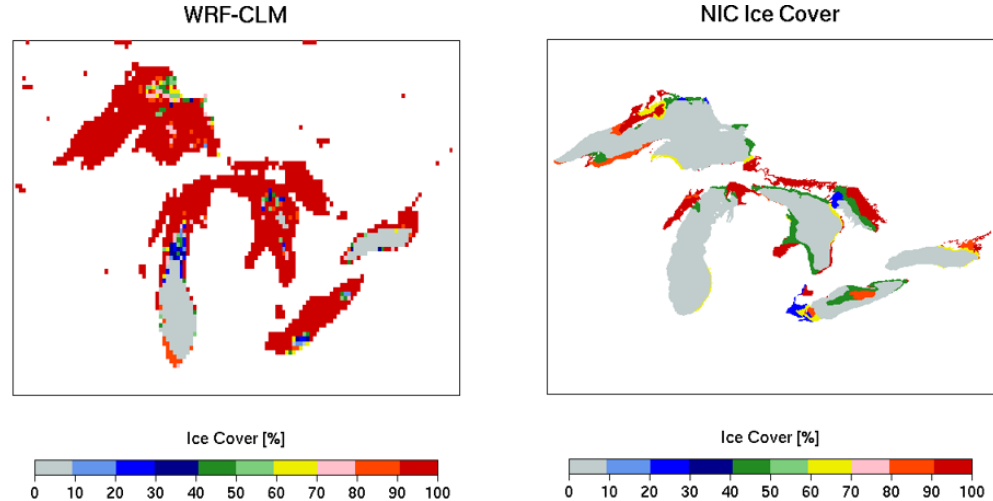
Figure 4. Simulated ice cover (%) taken from a WRF simulation (valid 2 March 2006, after ∼ 4 months of simulation time) with the same model configuration as described in M14, but simulated with WRF version 3.6 and the use of the CLM lake model in place of FLake (left). A 2-D field of lake depths (instead of a single default value) was used from WPS to set the lake depth in this simulation. Ice coverage observed on this date is plotted from the NIC ice analysis